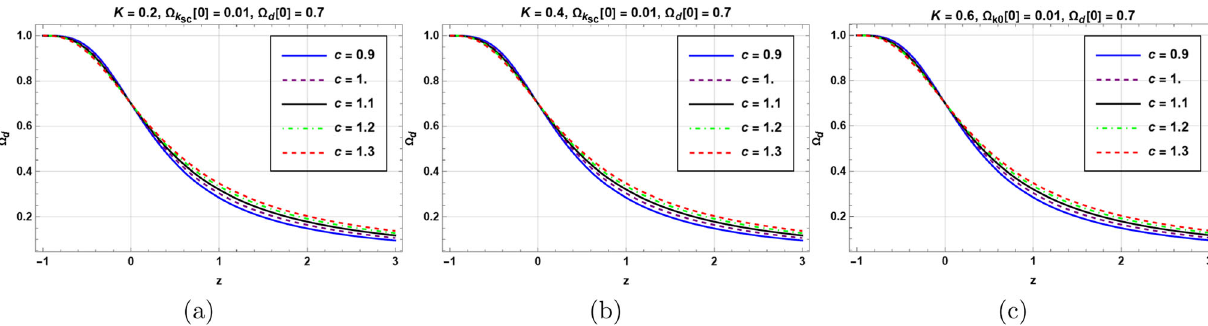
Fig. 1 The variation in the KHDE density parameter (cid:2) d with redshift z for the closed universe, in units when M 2 p = 1 , H 0 = 67 . 9. In order to be consistent with data, we now imposed (cid:2) d ( x = − ln ( 1 + z ) = 0 ) = (cid:2) d [ 0 ] = 0 . 7